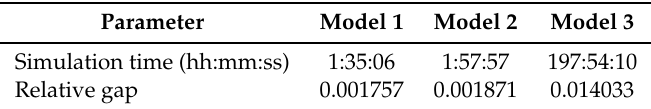
Table 7. Simulation parameters’